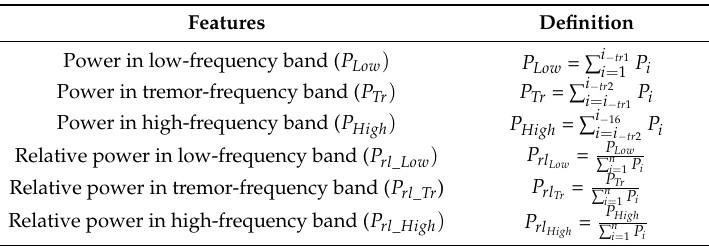
Table 3. Features derived for the three frequency bands.